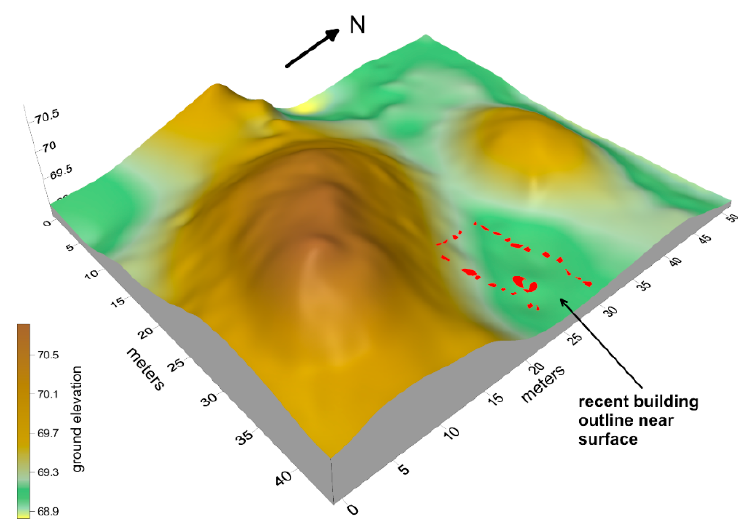
Figure 2. Topographic image of the Shadforth’s Mounds showing the location of the recent structure between the north and south mounds.